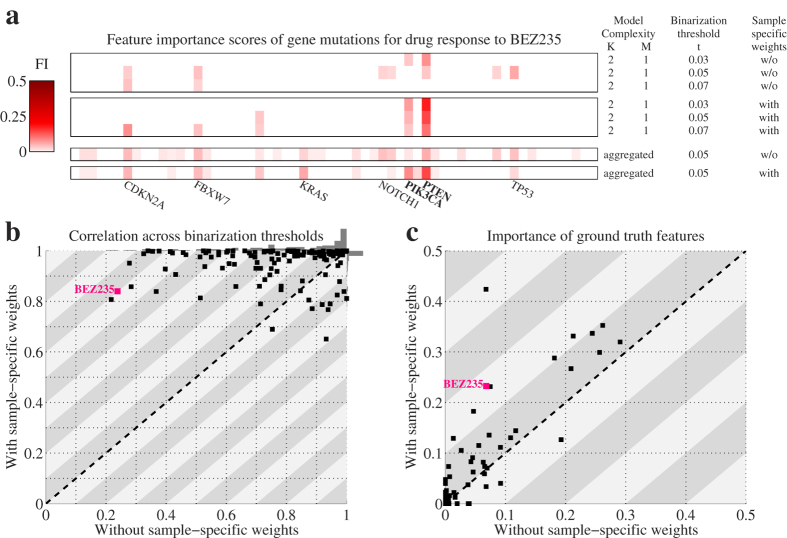
LOBICO’s use of continuous output leads to robust and accurate models.(a) Heatmaps depicting the feature importance (FI) scores across the 60 gene mutations for the logic models inferred to explain the drug response to the PI3K/mTOR inhibitor BEZ235. The upper heatmap represents FI scores for the 2-input OR model (K = 2, M = 1) using three different binarization thresholds for logic models with binarized output, i.e. not using the sample-specific weights. The middle of the three heatmaps represents the same FI scores, but for logic models with continuous output, i.e. using the sample-specific weights. The bottom two heatmaps depict FI scores aggregated across all model complexities, using the standard binarization threshold (t = 0.05), for both the logic models with and without the sample-specific weights. The labels of the gene mutations with a large FI in any of these heatmaps are printed below. The ‘ground truth’ features, i.e. the expected or annotated targets of this drug, PTEN and PIK3CA, are printed in bold. (b) Scatter plot with the average Pearson correlation coefficients of the similarity of FI scores across the binarization thresholds for inferred logic models without (x-axis) and with (y-axis) the sample-specific weights. Each point represents one of the 142 drugs. The correlation scores are computed using the model-complexity-specific FI scores. The grey bars on top and to the right of the scatter plot represent histograms of these correlation scores for models without and with the sample-specific weights, respectively. (c) Scatter plot with the importance of the ground truth features for inferred logic models without (x-axis) and with (y-axis) the sample-specific weights. Each point represents one of the 49 drugs, for which ground truth features were available. The importance scores of the ground truth features were derived from aggregated FI scores.